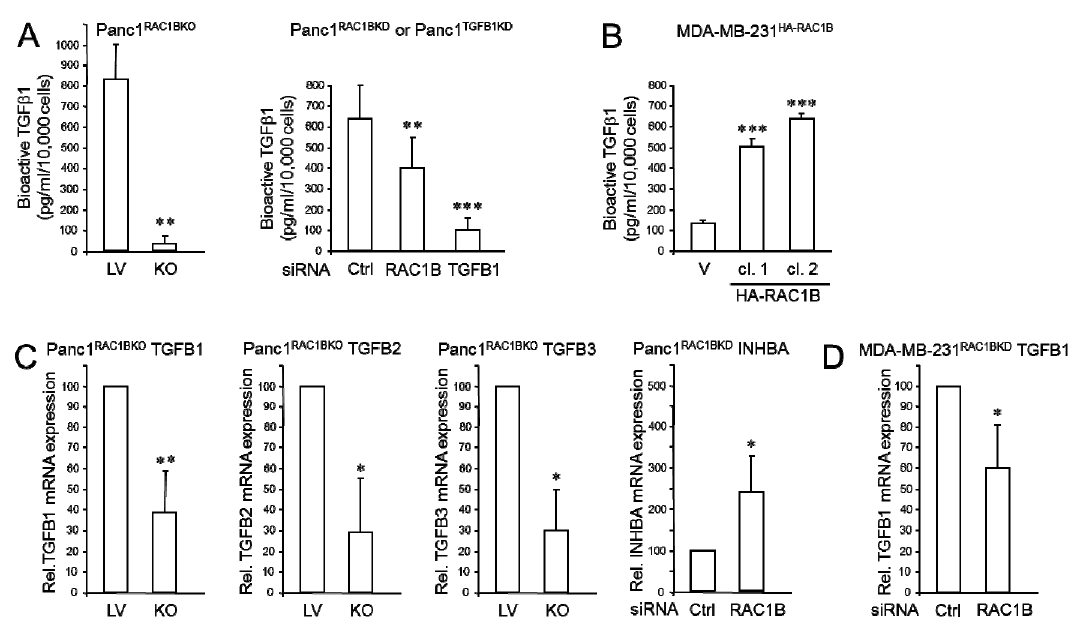
Figure 1. RAC1B depletion controls TGF β 1 gene expression and secretion in Panc1 and MDA-MB-231 cells. ( A ) Concentration of bioactive TGF β 1 in culture supernatants, as measured by ELISA, of Panc1 cells genetically engineered to lack exon 3b of RAC1 and hence expression of RAC1B (Panc1 RAC1BKO ) or empty lentiviral vector (LV) control cells [7] (827.4 ± 166.9 vs. 35.2 ± 40.7, n = 4, p = 0.0012, left-hand graph), or Panc RAC1BKD and ctrl cells (393.3 ± 98.2 vs. 264.8.2 ± 98.3, n = 3, p = 0.0038) or Panc1 TGFB1KD and ctrl cells (393.3 ± 98.2 vs. 85.5 ± 38.9, n = 3, p = 0.029, right-hand graph). Cells were